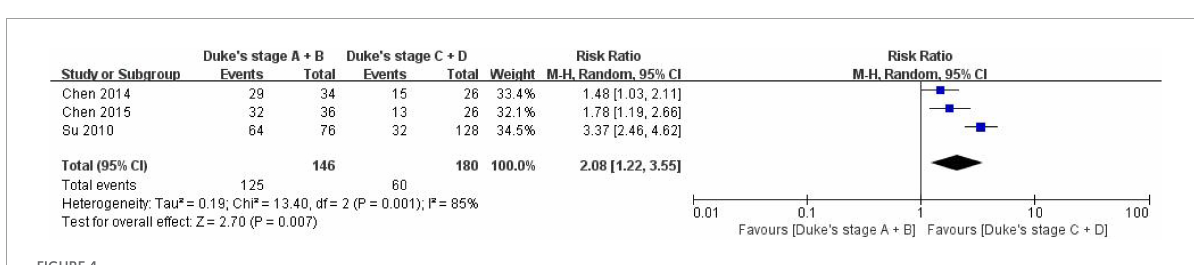
FIGURE4 Forest map related to CD24 expression and dukes staging.